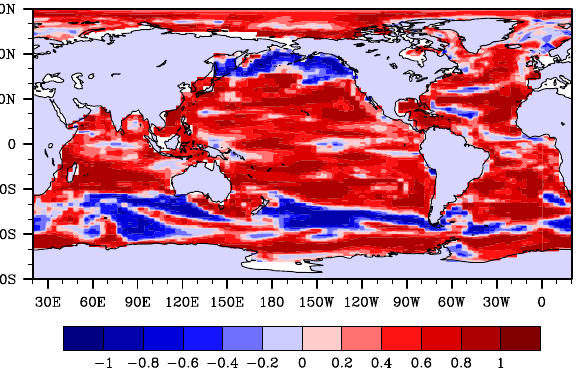
Fig. 10. Spearman correlation ( S c ) of diatom fraction with export efficiency. Trends were removed from the time series before calcu- lation. Significance has been tested at significance level α = 0 .